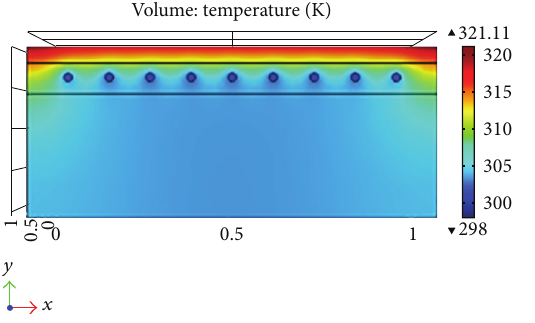
Figure 10: Temperature variation within asphalt layers for 100 × 75 str arrangement.